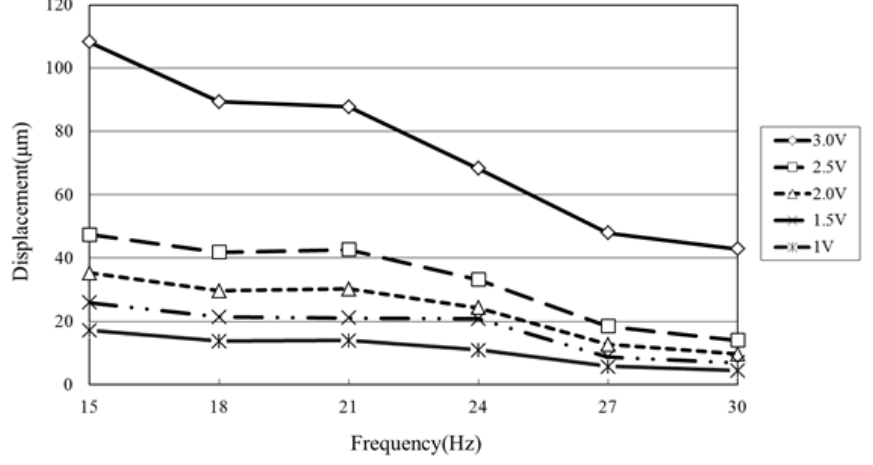
to four-layer microcoil